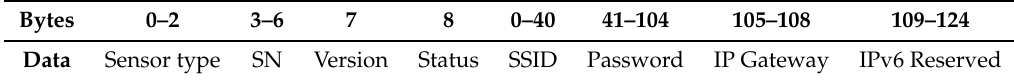
Table 2. Memory division of the microcontroller EEPROM in bytes.